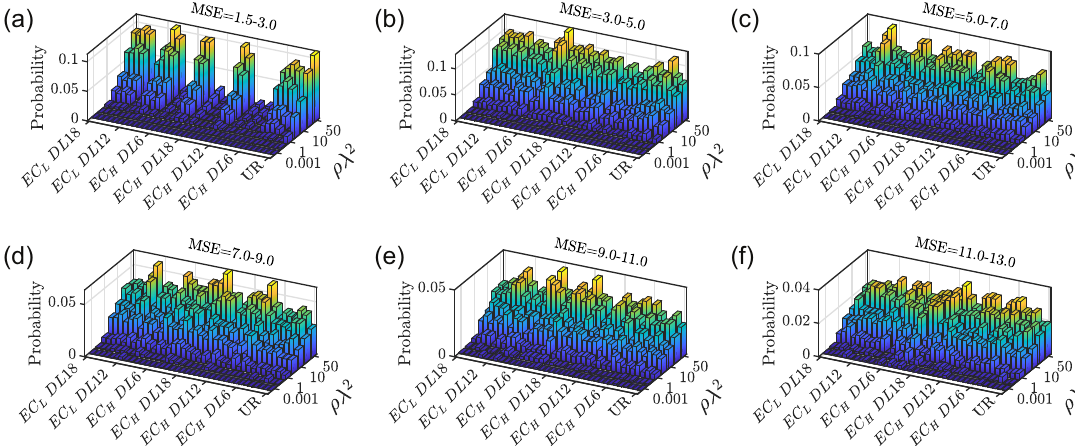
Figure 10. Probability distribution of scattering resonances as a function of ρλ 2 of 36 representative EC DL geometries as compared to UR structures for various MSE intervals ( a – f ). Specifically, the UR configuration is reported in the first row of each panels. The reported EC DL structures are generated by randomly selecting 9 integers starting points W on the two elliptic curves defined by the parameter combination ( a = 27; b = 4; ) , and ( a = 28; b = 19; ) over the finite field F 2111 , respectively. These two EC point patterns are the EC H and EC L structures introduced in Figure 6. Each selected integer W generates two different EC DL aperiodic point patterns by solving the two discrete logarithmic problems W = kM x and W = kM y , where M x and M y are the components of a each point M of EC that satisfies these two relations (see Section 2 and in the caption of Figure 1 for more details). In particular, the 9 integer points selected on the EC H are: (1893;1826), (114;1753), (375;1739), (340;936),